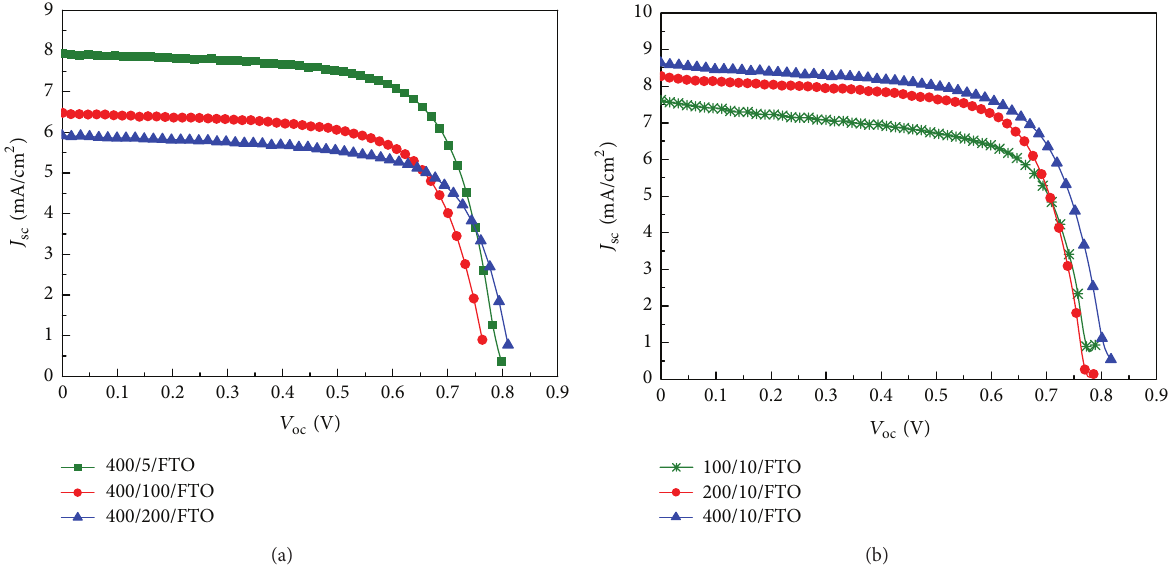
Figure 5: The photocurrent-voltage curves of DSSCs with double-layer structures of different TiO 2 particle sizes in the (a) bottom and (b) top layers, respectively.